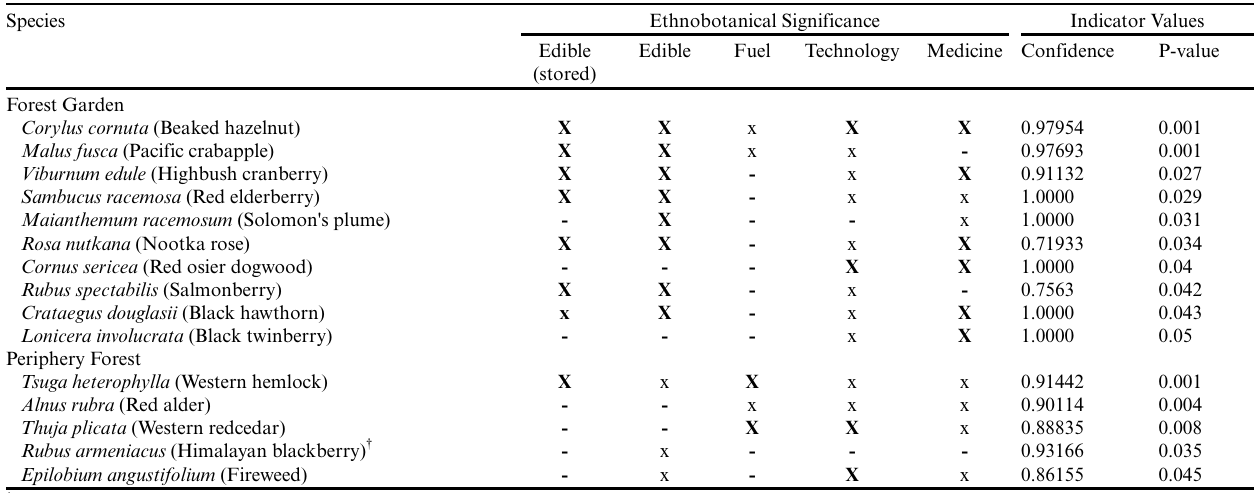
Table 1 . Indicator species and ethnobotanical significance of forest gardens and periphery forests based on Turner (2014). Indicator species differed significantly between both site types. Key: X , extensive use; x, some use; -, use not determined.